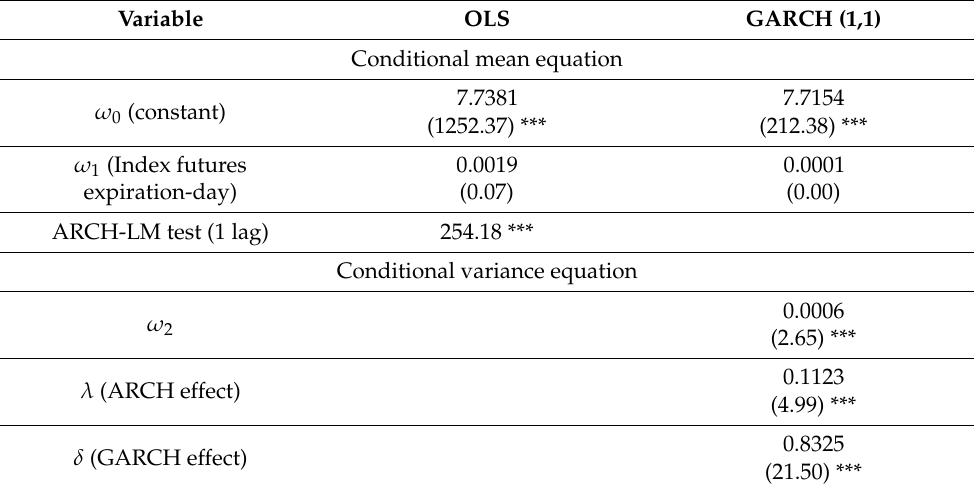
Table 4. The impact of index futures expiration-day on the spot market trading